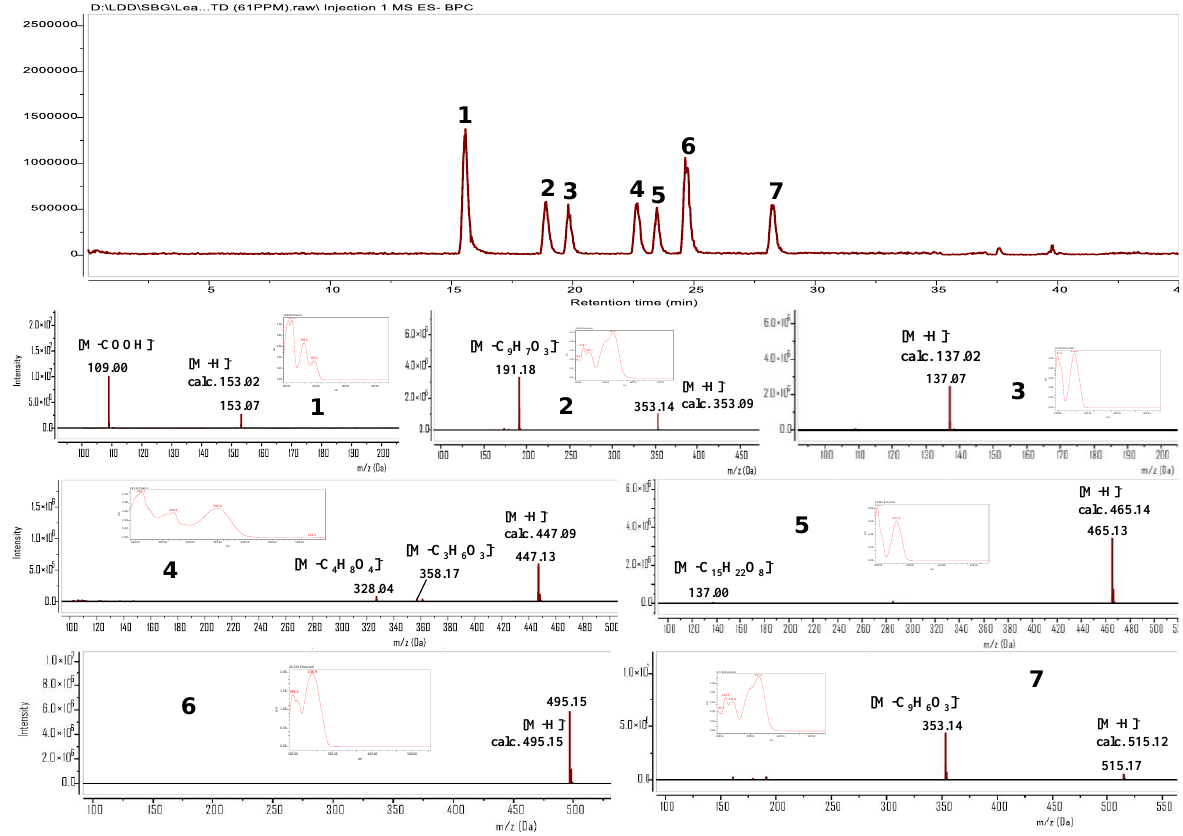
Figure 1. UV- and MS spectra of marker compounds ( 1 – 7 ).